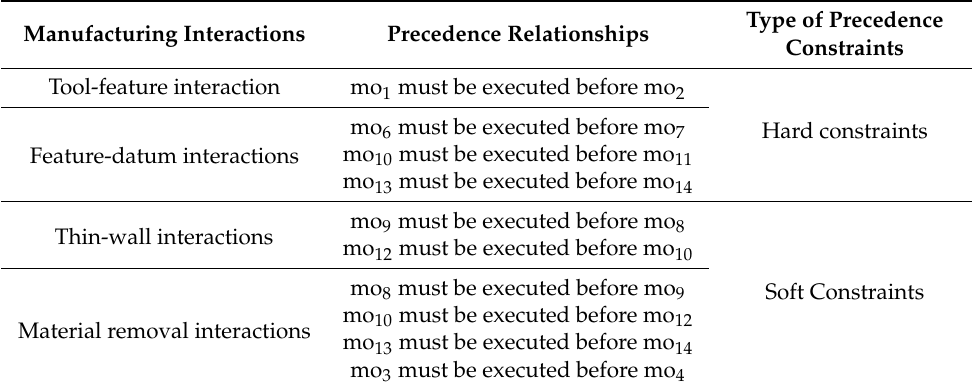
Table 4. Precedence relationships for prismatic part 2.